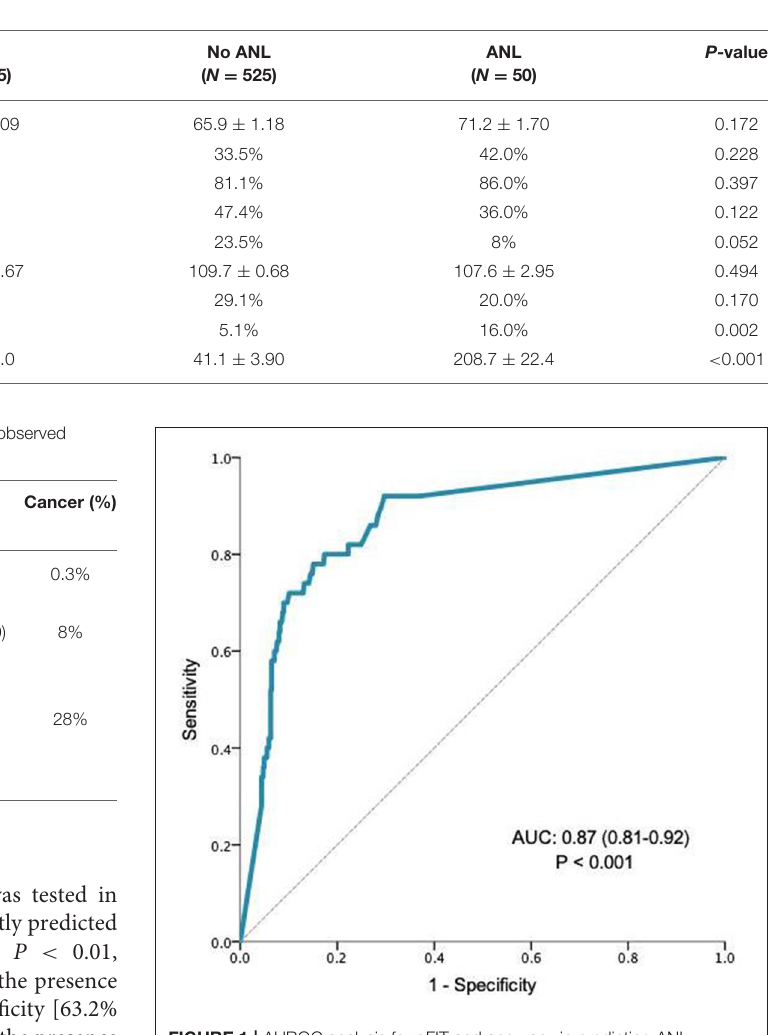
FIGURE 1 | AUROC analysis for qFIT and accuracy in predicting